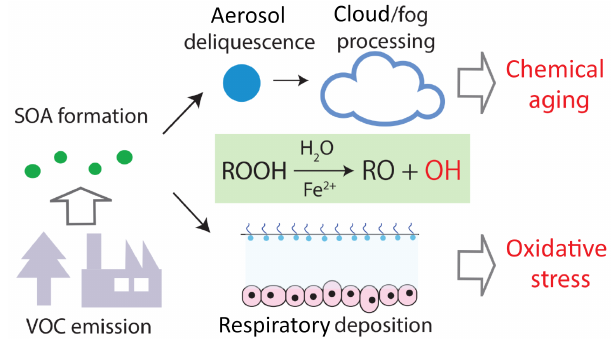
Figure 8. Implications of OH formation by SOA. Formation of OH radicals upon decomposition of organic hydroperoxides (ROOH) in secondary organic aerosol leads to rapid chemical aging of SOA particles upon deliquescence and cloud or fog processing in the at- mosphere as well as oxidative stress upon inhalation and deposition in the human respiratory tract. Mixing and Fenton-like reactions of iron with ROOH from SOA can occur both in atmospheric particles and in the lung lining